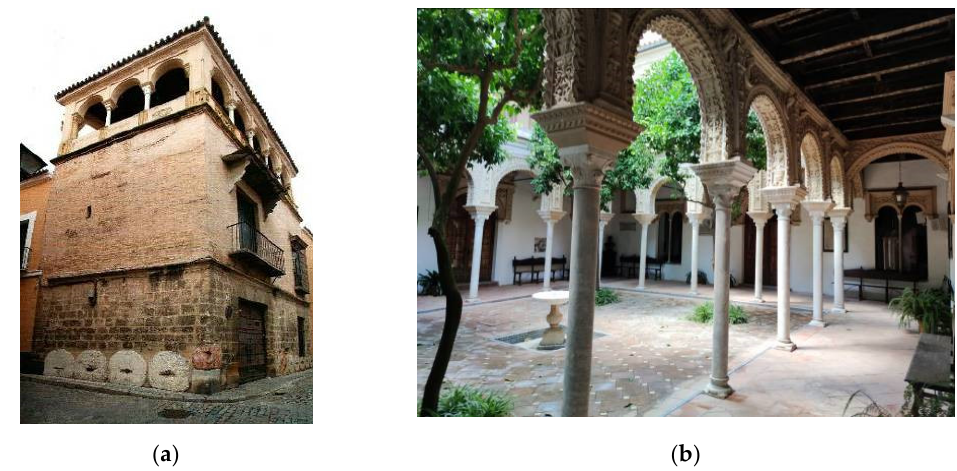
Figure 2. ( a ) Lookout tower on the façade. ( b ) Main courtyard view. Authors’ own photographs, 2020.